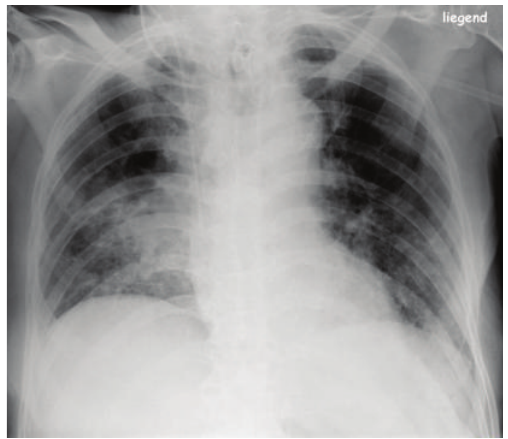
Figure 4: Consolidation in the right lower lobe due to aspiration in an 85-year-old patient (aspiration was confirmed using fluo- roscopy).